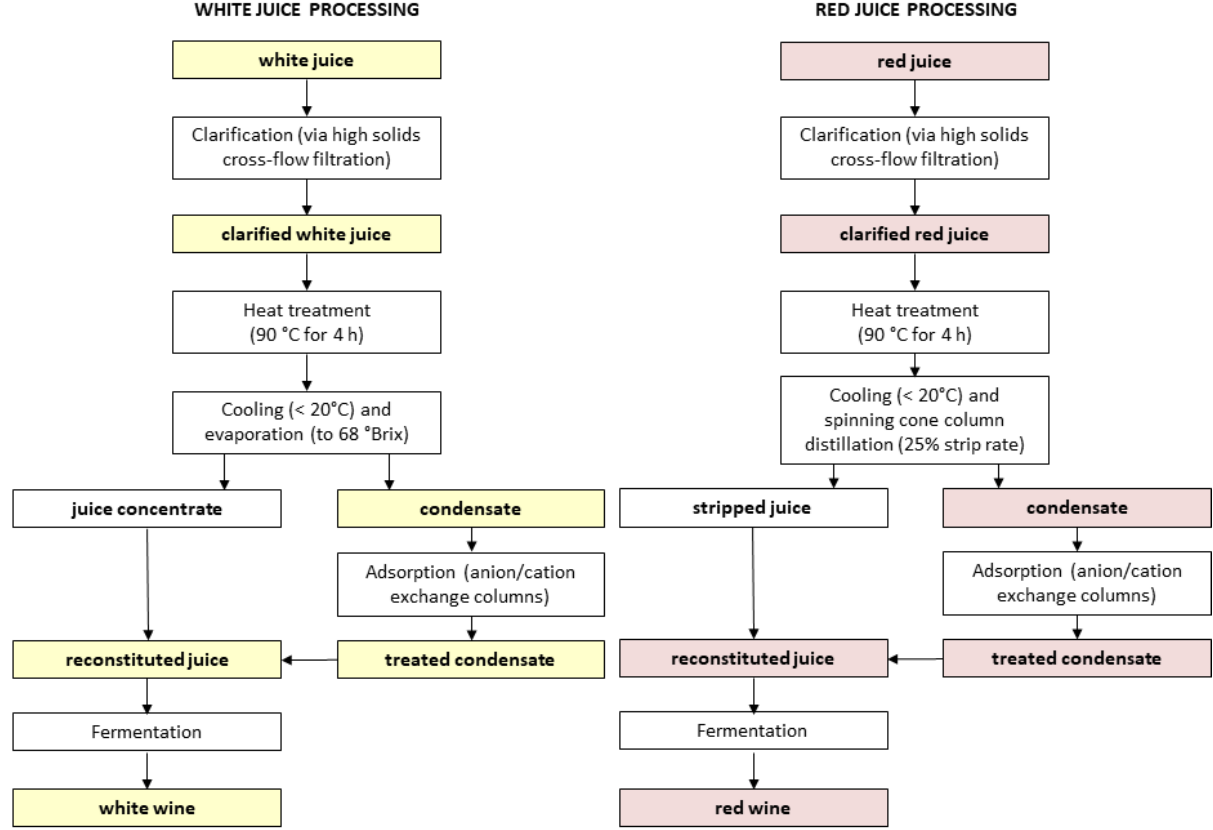
Figure 3. Flowcharts of processes used to remediate white and red juices derived from smoke-affected grapes. Colored boxes represent samples collected for compositional analysis.